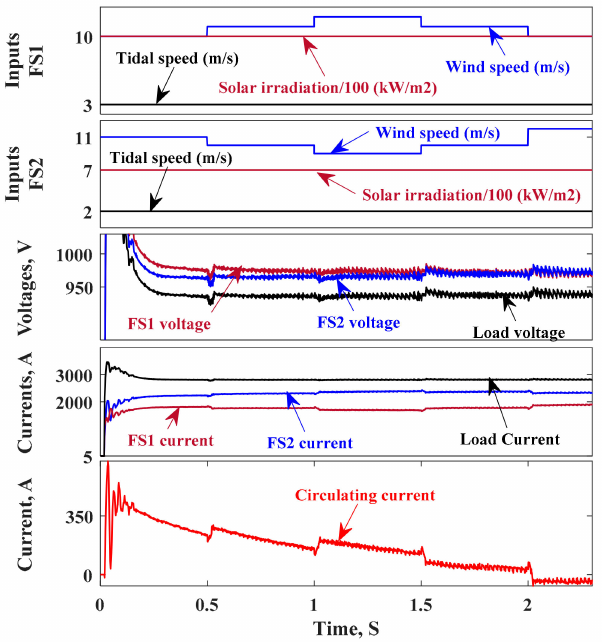
Figure 21. Simulation results of two floating energy units connected in parallel with 2-energy storage units.